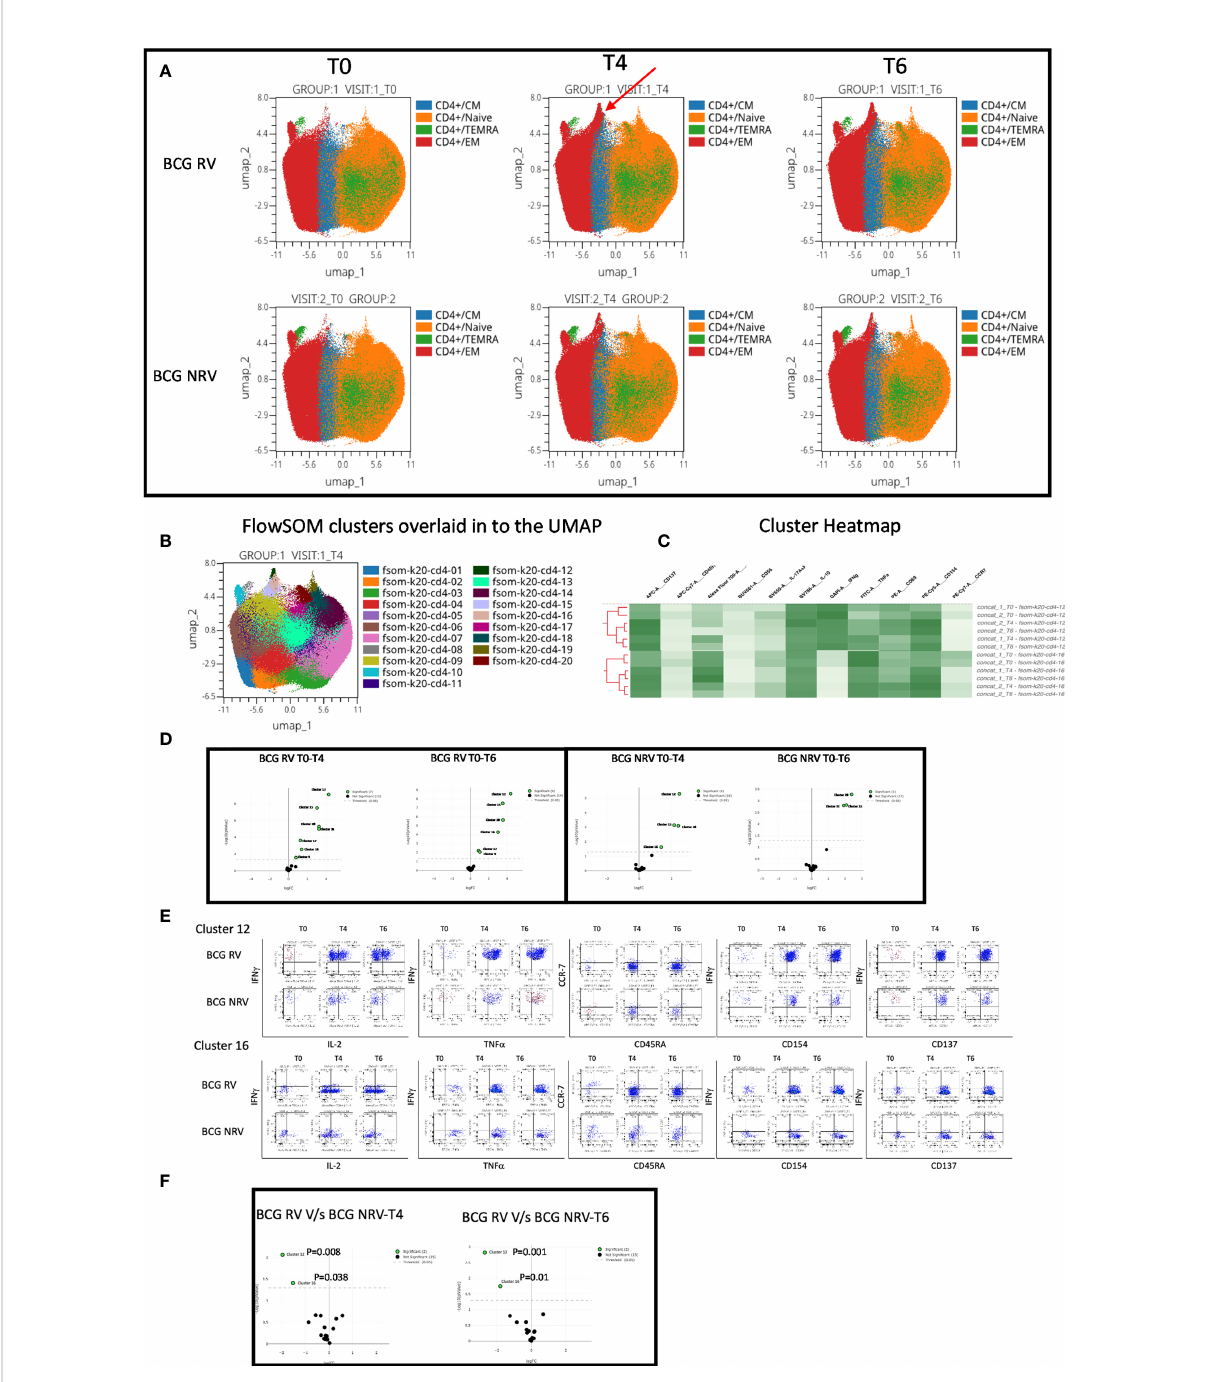
FIGURE 5 Overview of COVISHILED ™ vaccine induced spike speci fi c CD4+ T cell responses in BCG-RV and BCG-NRV subjects measured at baseline (T0), post-prime (T4) and post-boost (T6). (A) UMAP of COVISHIELD ™ vaccinated BCG-RV and BCG-NRV subjects. (B) Unbiased FlowSOM clusters overlaid in the UMAP projection axis. (C) Heatmap of cluster 12 and 16 in COVISHIELD ™ vaccinated BCG-RV and BCG-NRV subjects. (D) Volcano plot of fold change in all FlowSOM clusters in COVISHIELD ™ vaccinated BCG-RV and BCG-NRV subjects. (E) Bivariate dot plot of Cluster 12 and cluster 16 in COVISHIELD ™ vaccinated BCG-RV and BCG-NRV subjects. (F) Volcano plot of fold change of all clusters between BCG-RV and BCG-NRV subjects at T4 and